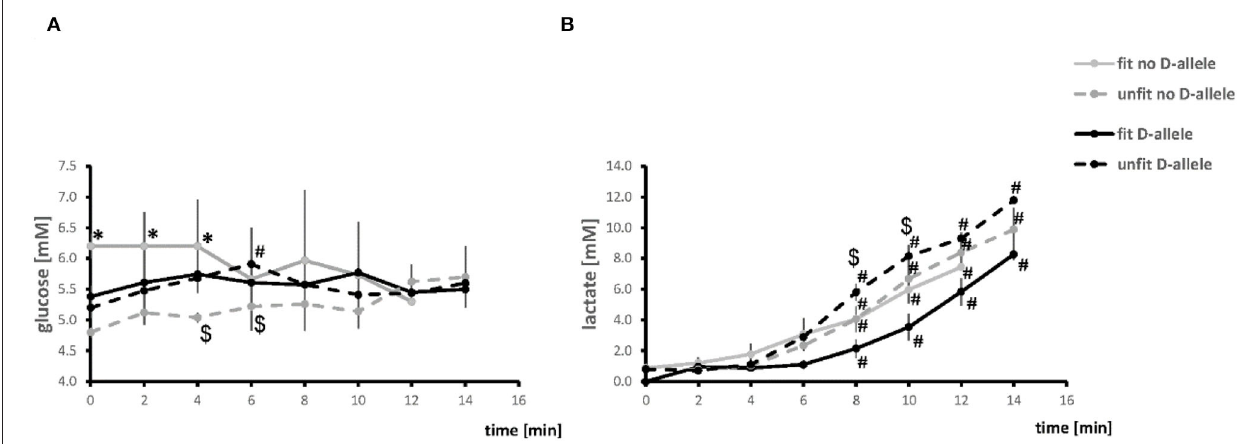
FIGURE 2 | Timeline of alterations of blood metabolites during the pedaling phase of exercise test. Line graph visualizing the mean values of glucose (A) and lactate (B) concentration in blood during the pedaling phase of exercise. # p < 0.05 vs. 0min, * p < 0.05 vs. unfit, same genotype. $ p < 0.05 vs. other genotype, same fitness state. Note, the time to exhaustion was two min shorter for the fit D-allele non-carriers, because the all-male group had a steeper ramp protocol.